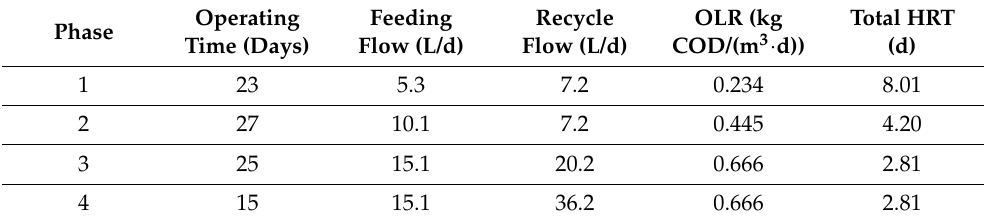
Table 3. Conditions of operation performed during the operation of the CFR system. Phase